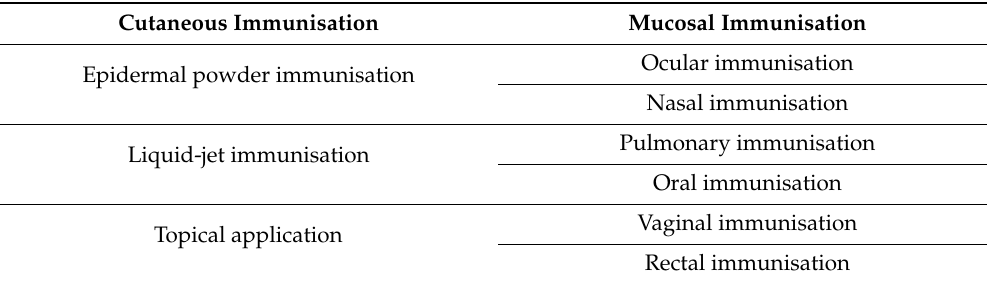
Table 1. Various alternatives to intramuscular application